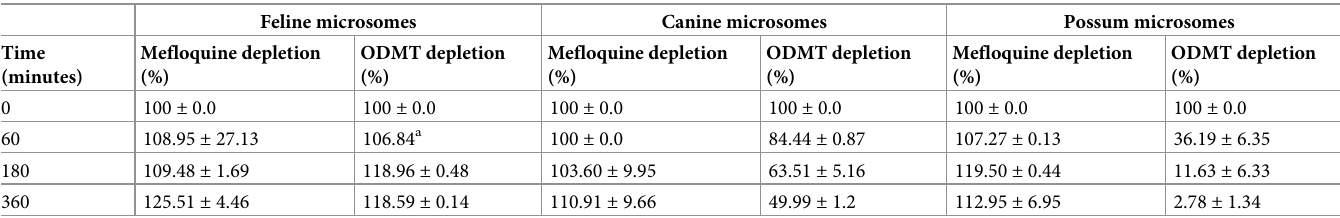
Table 1. Mefloquine and ODMT (as positive control) depletion as a percentage over time (mean ± S.D.) for the microsomal incubations of each